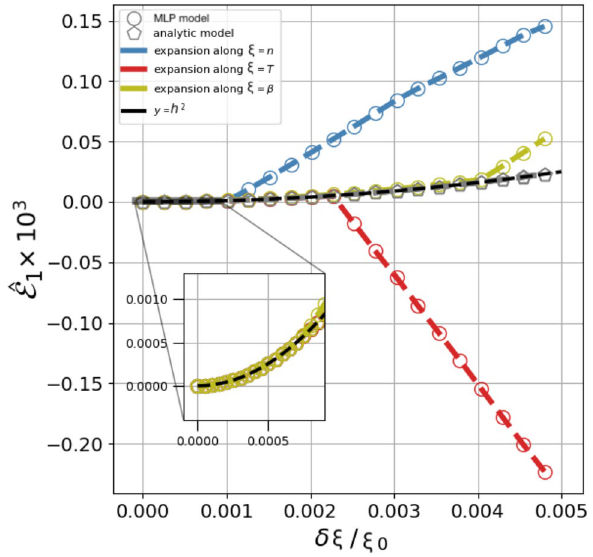
Figure 2. Smoothness test: plot of the scaled residual of a first order Taylor expansion 3 x E 1 E 2 / E 2 ( h 10 0, ξ ) , with respect to each thermodynamic variable, n , T , β (no sample averaging over the − ˆ = ≈ expansion point was computed). The open gray pentagons represent the three overlapping expansions for the analytic flux function q in Eq. (13). The blue, red and olive symbols (circles + dash-line) show the expansions with respect to n , T , β , respectively, for the case of the MLP representation. The black solid line is the parabolic curve that all scaled residual errors are expected to follow, an expectation fulfilled by the analytic case, but not the MLP representation, except that for a very short